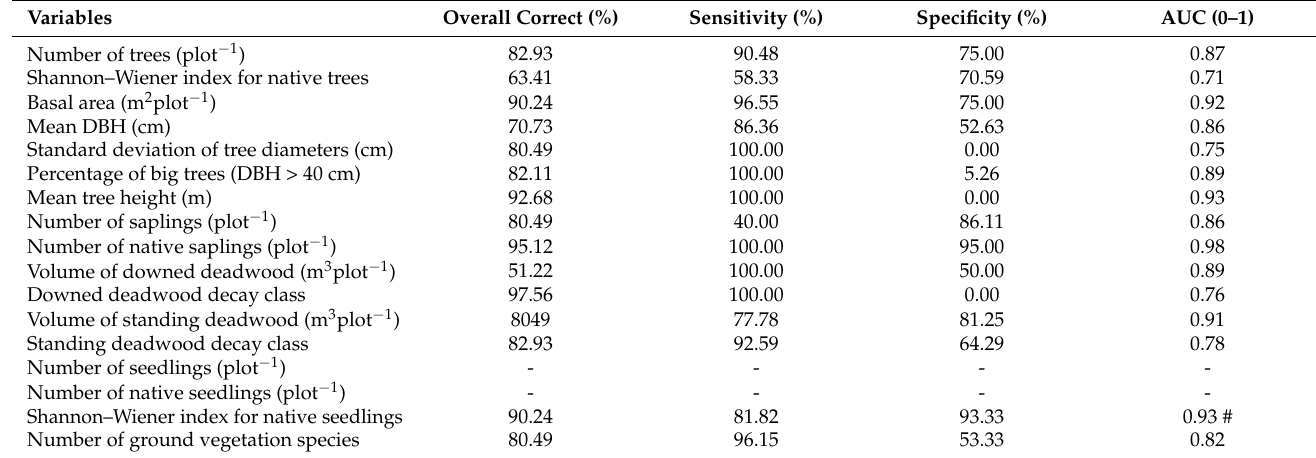
Table 6. Summary of logistic regression applied to the estimates from models created from leaf-on, leaf-off or combined models for the 17 indicator metrics identified in Table 1 (and Table S2). Predicted values were assessed against these indicator metric targets and assigned a 1 if they exceeded this, or a 0 if they did not. These values were then assessed against the equivalent field value. (#